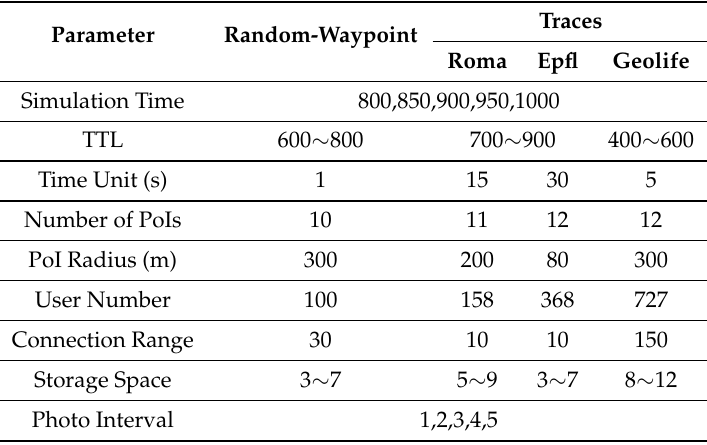
Figure 11. The PoI areas in Baidu map of the three real-world data sets. Table 2. Simulation